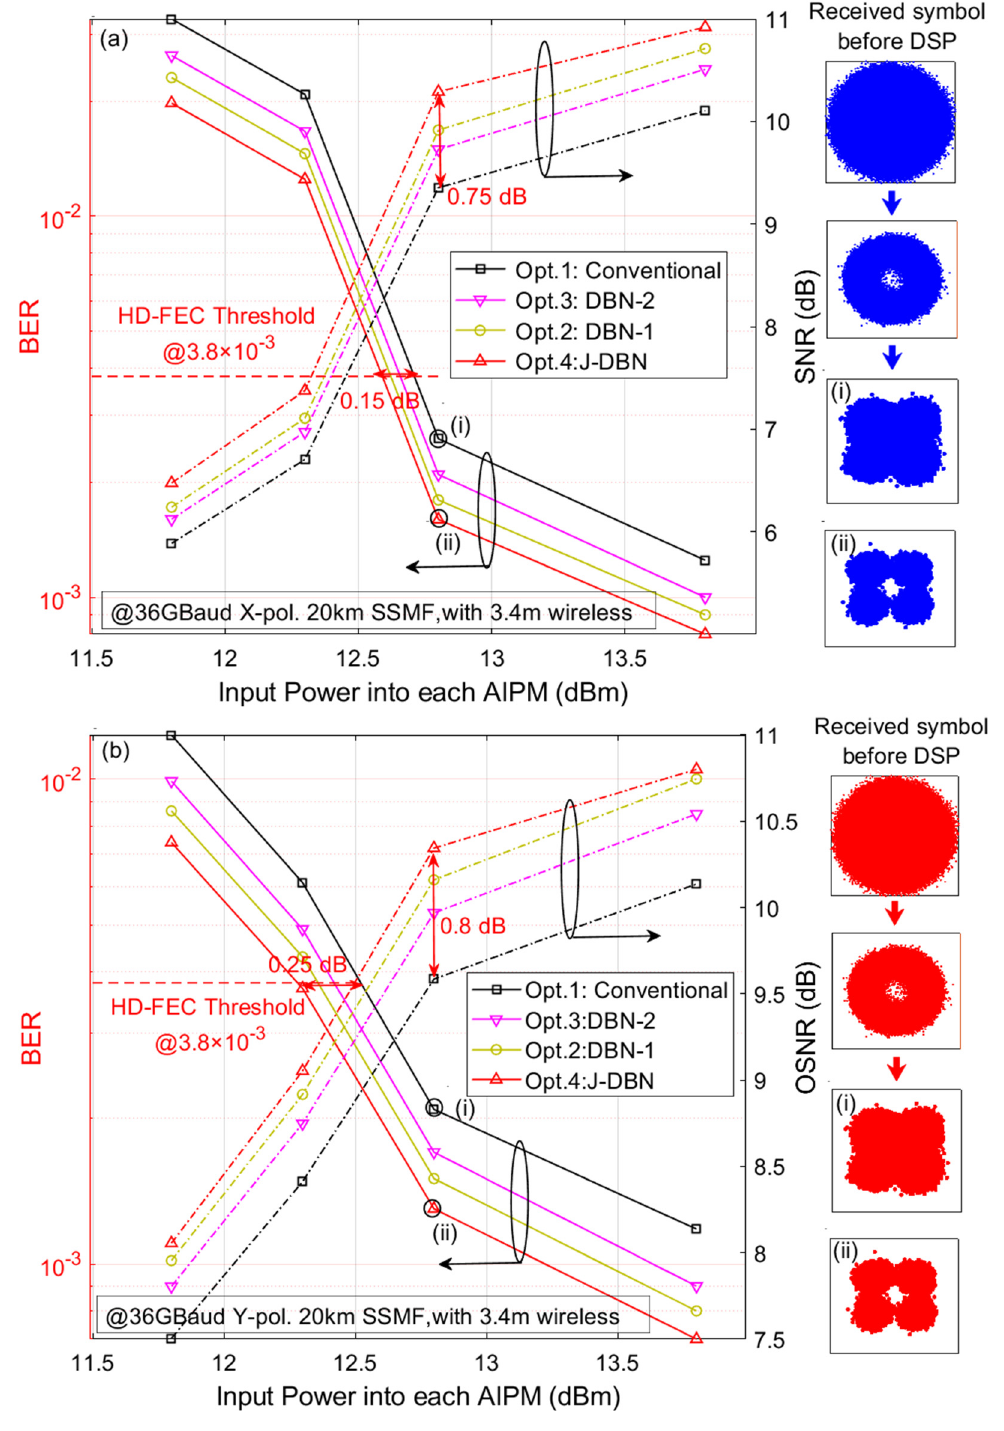
Figure 7. BER versus input power into each AIPM over one span of 20-km SSMF and 3-m wireless transmission for different proposed equalizers. ( a ) X-polarization. ( b ) Y-polarization.